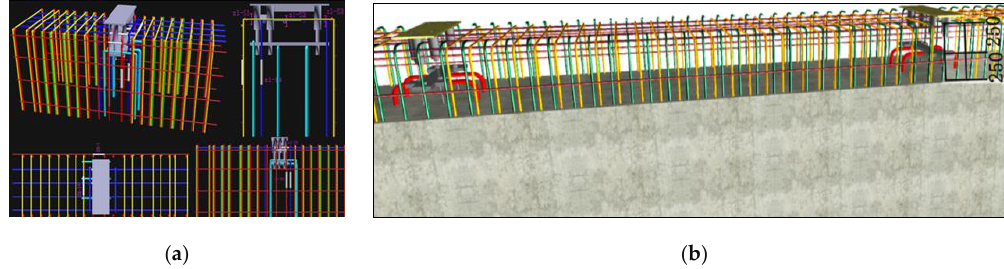
Figure 7. Anchor plates and the reinforcement: ( a ) Installation BIM model before pouring concrete, and ( b ) anchor plates welded to the reinforcement.